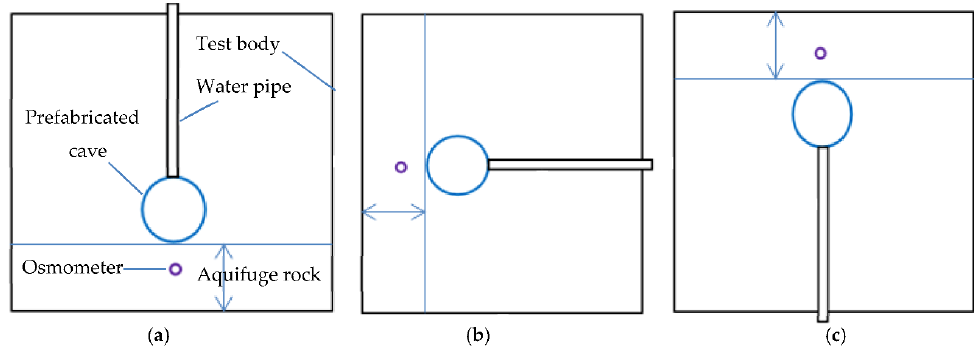
Figure 4. Picture of the indoor test. ( a ) The vault cavity; ( b ) the cavity in front of the tunnel face; ( c ) the cavity at the bottom of the arch.